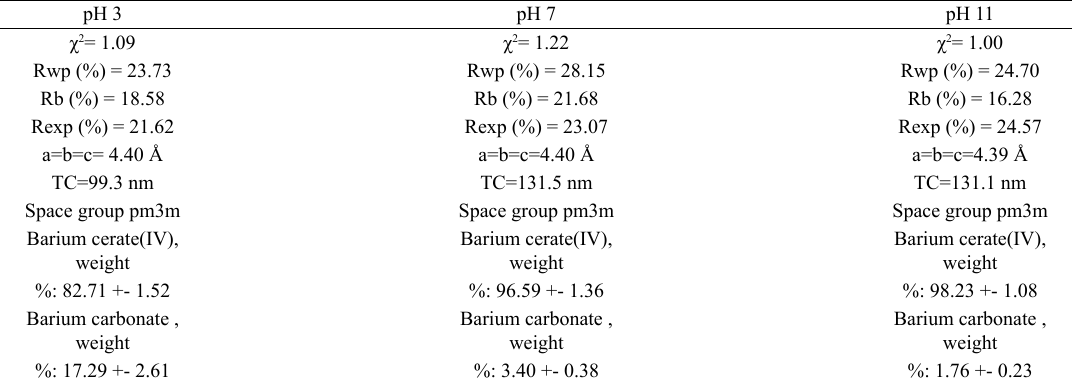
Pr Cu O powders synthesized 0.8 0.05 0.15 3-δ Pr Cu O powders obtained with different pH values and calcined at 1000 °C. 0.8 0.05 0.15 3-δ